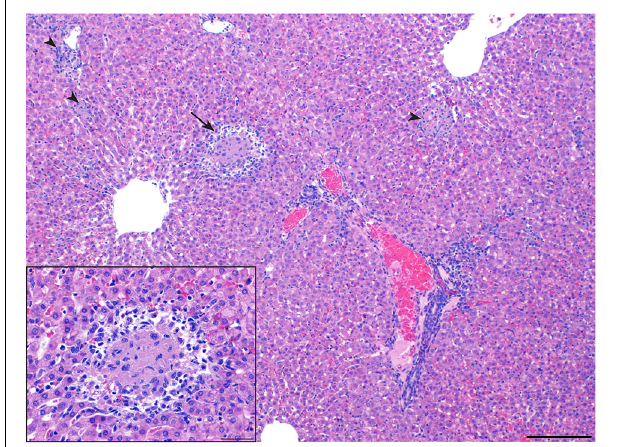
FIGURE 1 | Liver of a guinea pig at 28 days of infection by Brucella melitensis . The guinea pig was infected intratracheally with 10 6 CFU of B. melitensis 16M. Liver granuloma indicated by arrows (H&E, bar, 200 µ m). Areas of histiocytic inflammation with necrotic hepatocytes are randomly distributed (arrowheads). Inset, higher magnification of area indicated by arrow demonstrating central necrosis surrounded by neutrophils and macrophages (H&E, bar, 50 µ m).